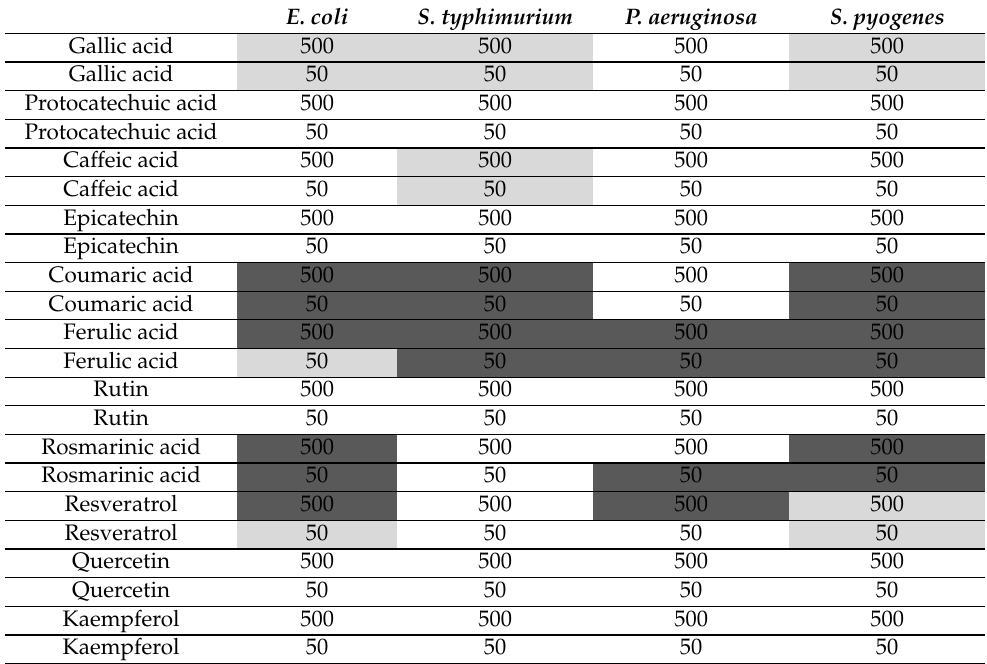
Table 5. The MIC ( µ L/100 mL) for polyphenol standards against the most sensitive